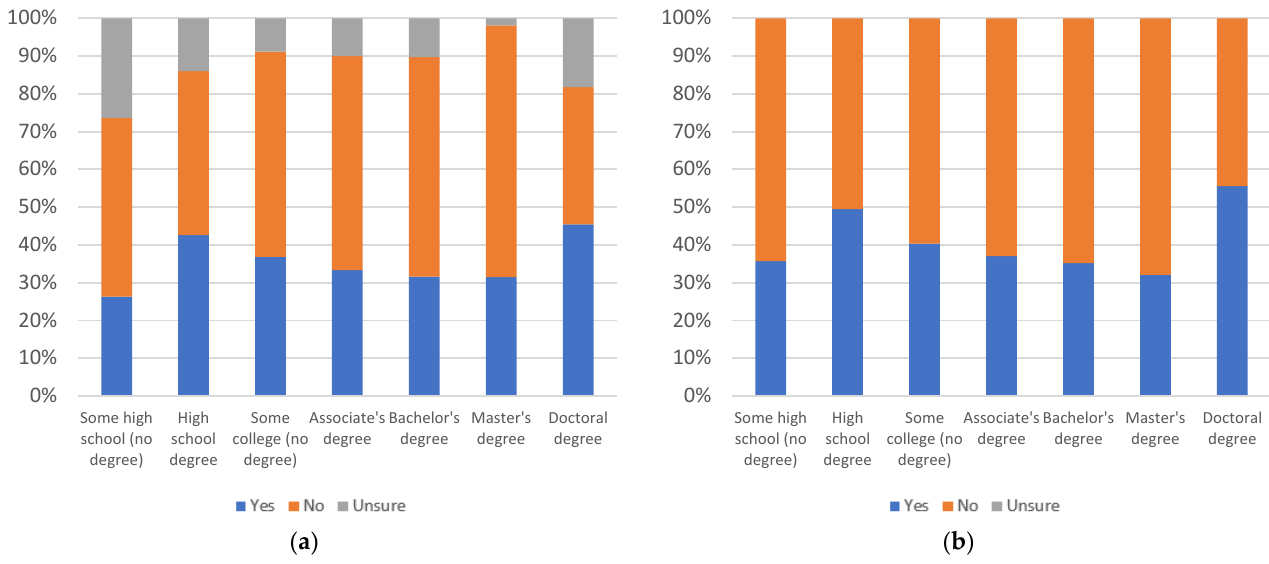
Figure 73. Label annoyingness, by education level: ( a ) with uncertain respondents (left) and ( b ) without uncertain respondents (right).